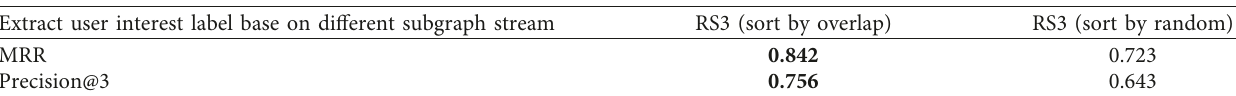
Table 4: Comparison of user interest label extraction effects under different subgraph stream construction strategies on